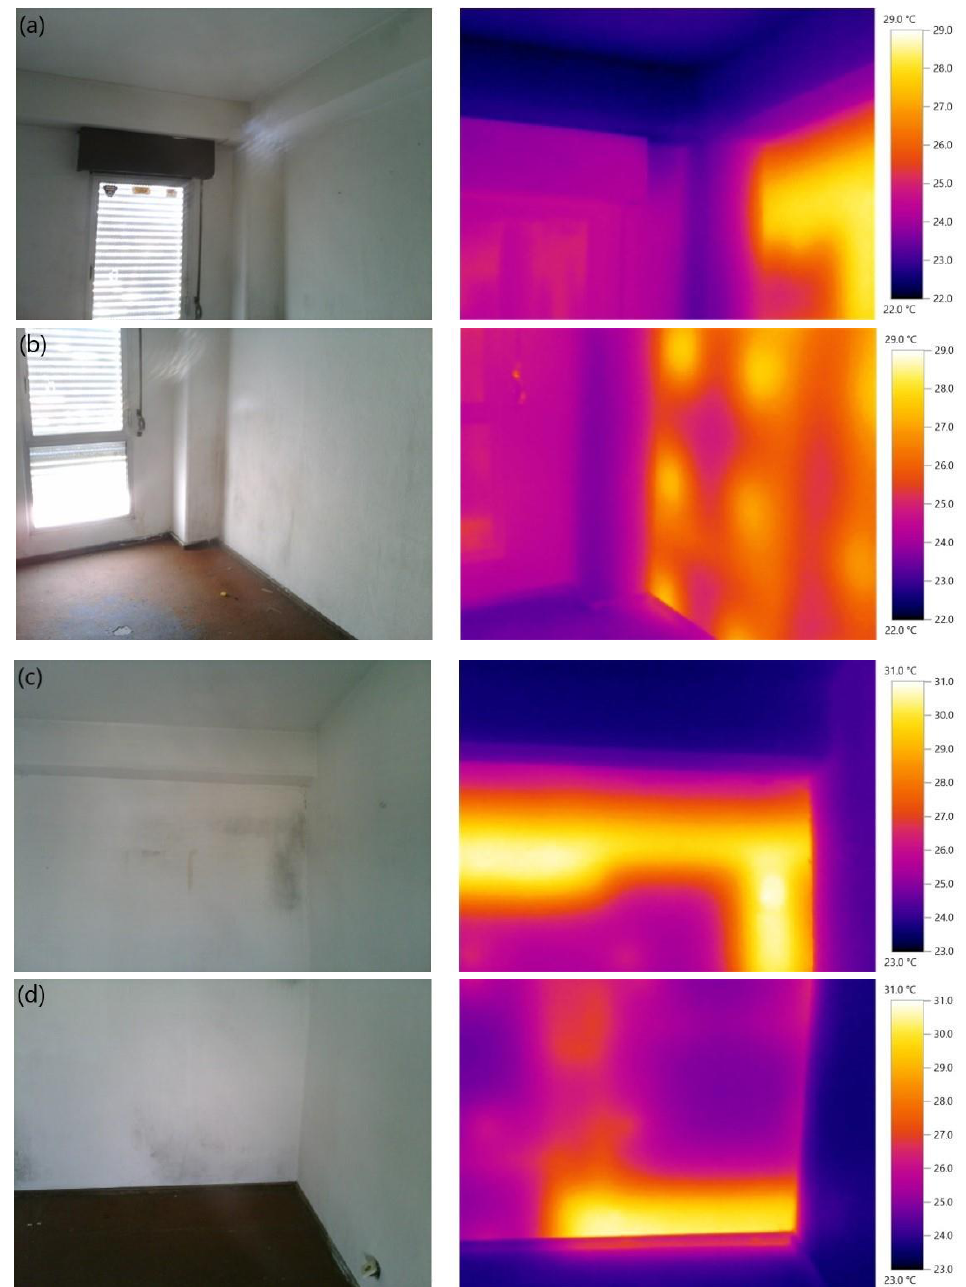
Figure 5. Representative surveyed photo (left) and thermal image (right): ( a ) 1 — Northern and eastern façades: connection ceiling/external wall; ( b ) 1 — Northern and eastern façades: connection external wall/internal floor; ( c ) 2 — Southern façade and internal partition: connection ceiling/external wall; ( d ) 2 — Southern façade and internal partition: connection external wall/internal floor.